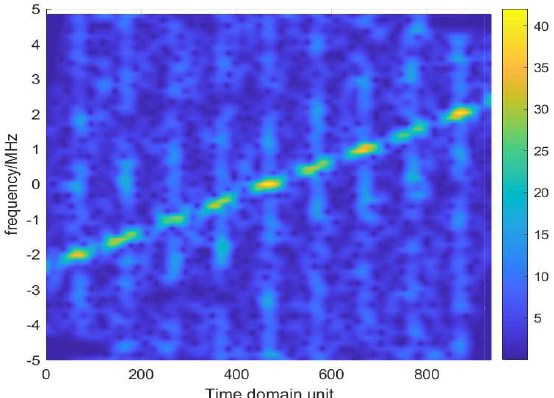
Figure 12. Time-frequency distribution of the residual signal after jamming